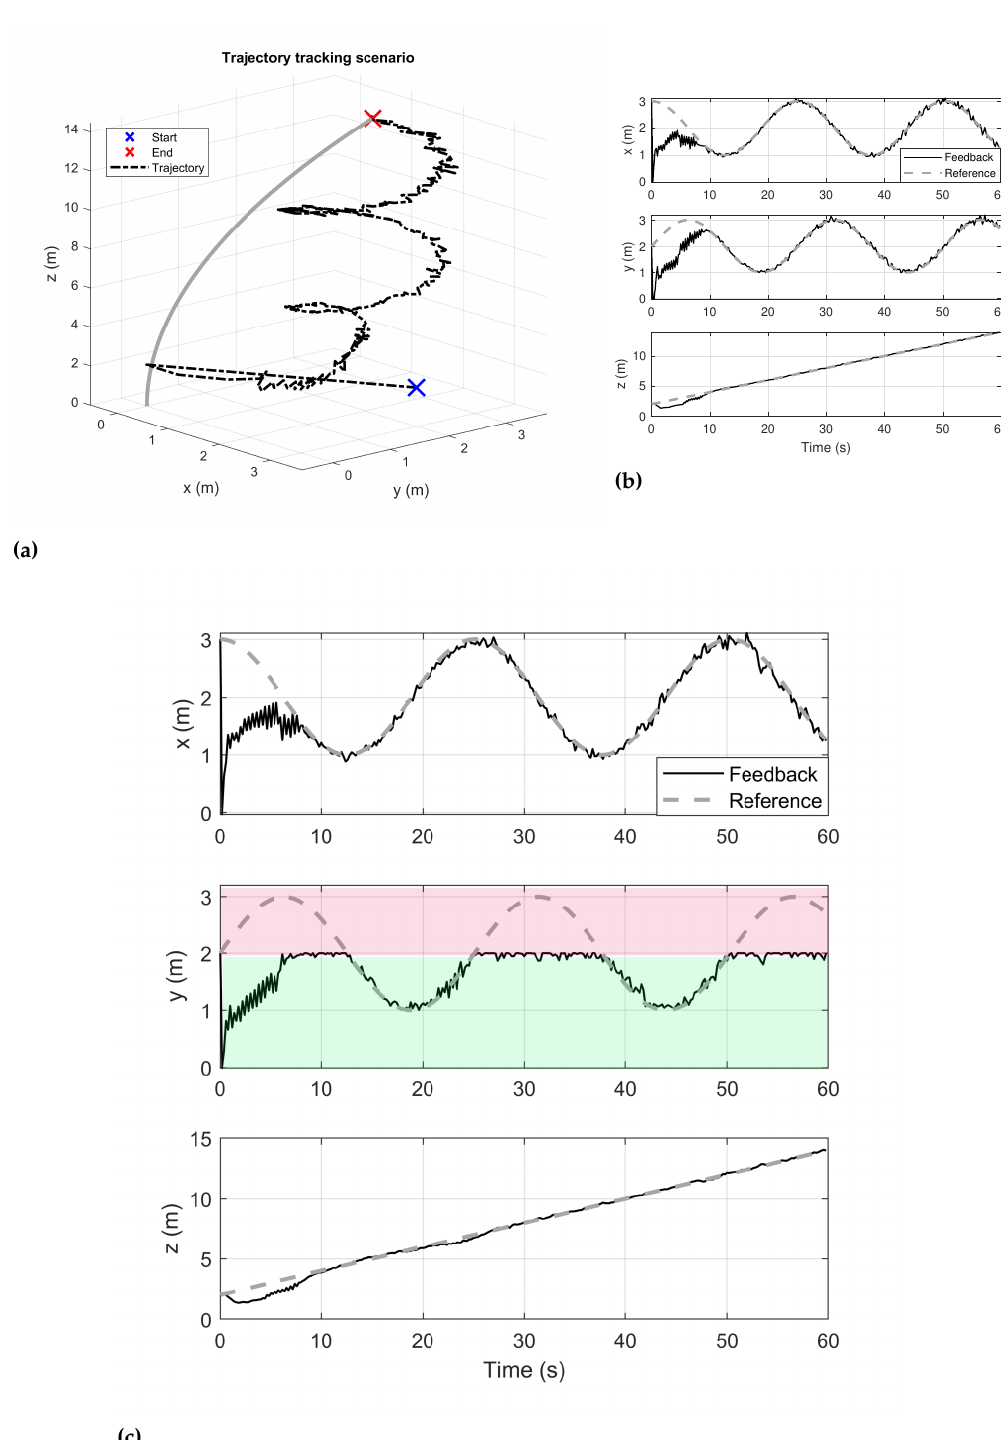
Figure 7. ( a ) The trajectory tracking performance of the proposed NMPC; ( b ) the corresponding state tracking in x , y and z coordinates. ( c ) The robot’s state in case of constraining the y-axis of the